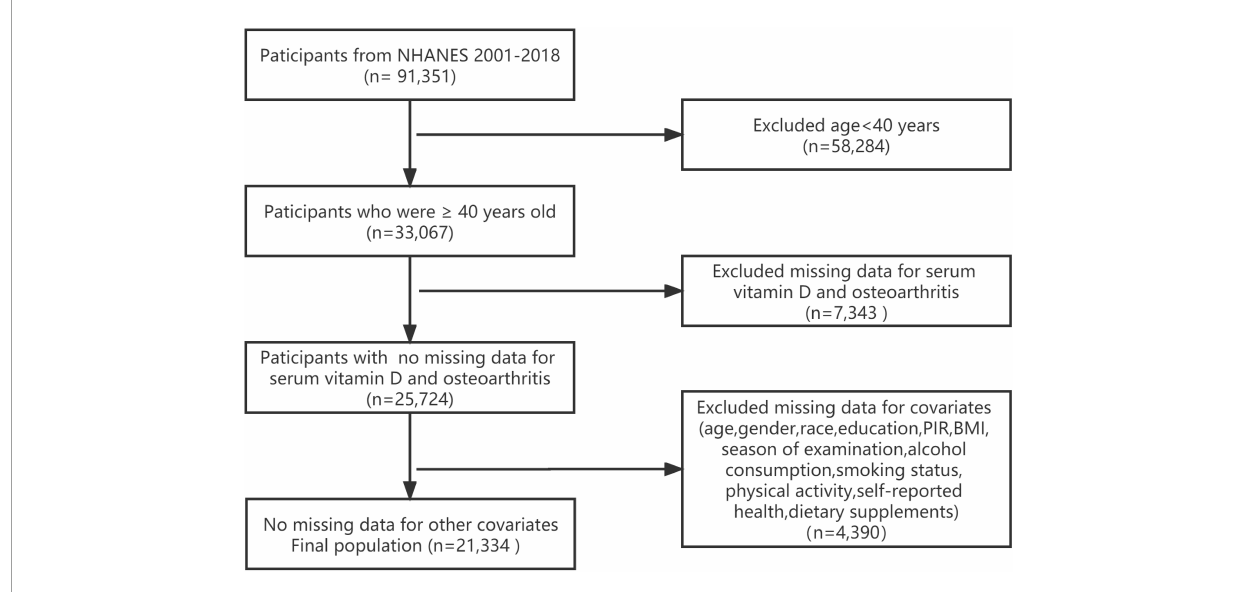
FIGURE1 Flowchart of participant